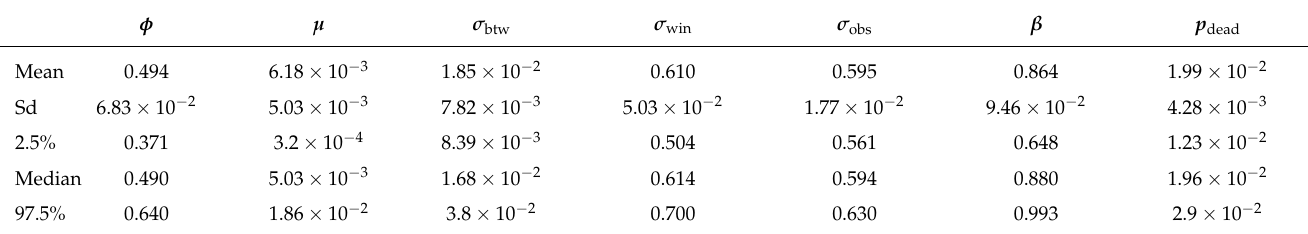
Table 2. Parameter location statistics derived from the Monte Carlo Markov chain. The range from the 2.5% value to the 97.5% value represents a highest-density 95% credible